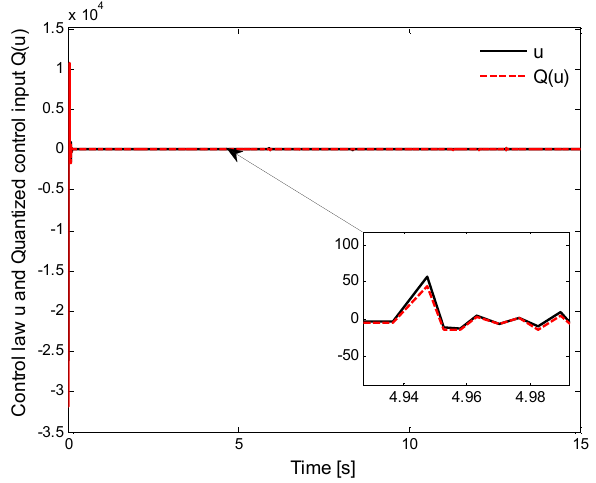
Figure 4. Trajectories of control law u ( t ) and quantized control input Q ( u ) .